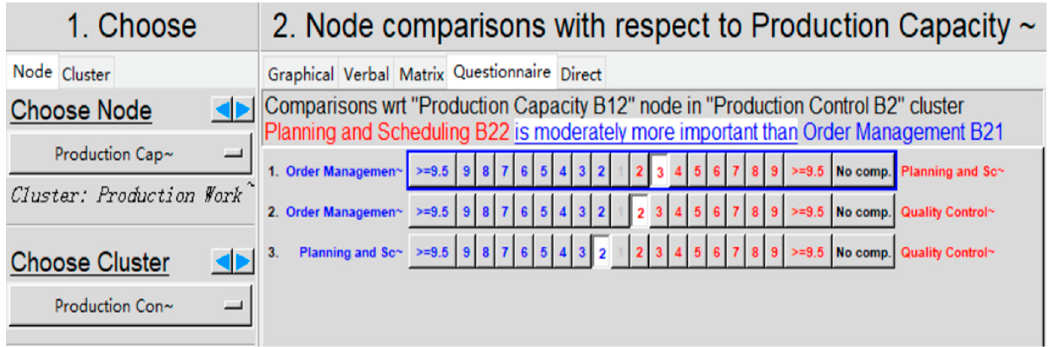
Figure 5. Comparison of elements under production automation criteria.